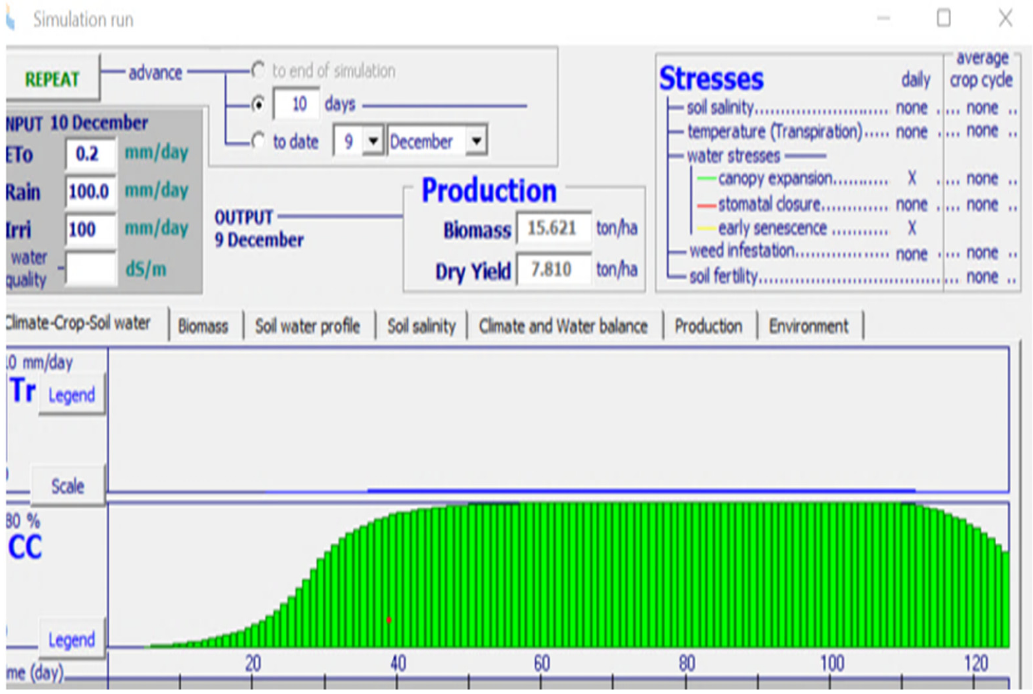
Figure 11. Canopy cover, biomass, and yield in the AquaCrop model for saffron.